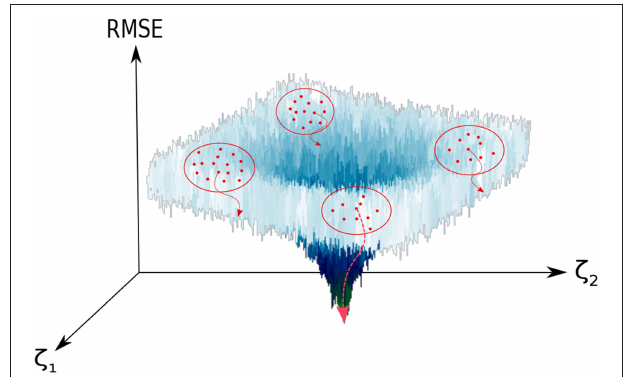
FIGURE 1 | Graphical representation of the optimization process of the set of SRP parameters ( { ζ } ). The vertical axis displays the RMSE between our reference data and our target function (see Equation 3), which in the figure depends just on two parameters ( ζ 1 , ζ 2 ). Non-overlapping clusters (red dots enclosed in a red circle) of walkers (red dots) are generated. In each cluster, the optimal solution is locally minimized (red dotted curved arrows) and compared to the rest of solutions. For a large enough number of clusters, convergence to the global minimum is guaranteed. In this representation, we have used a modified Ackley function ( Ackley,